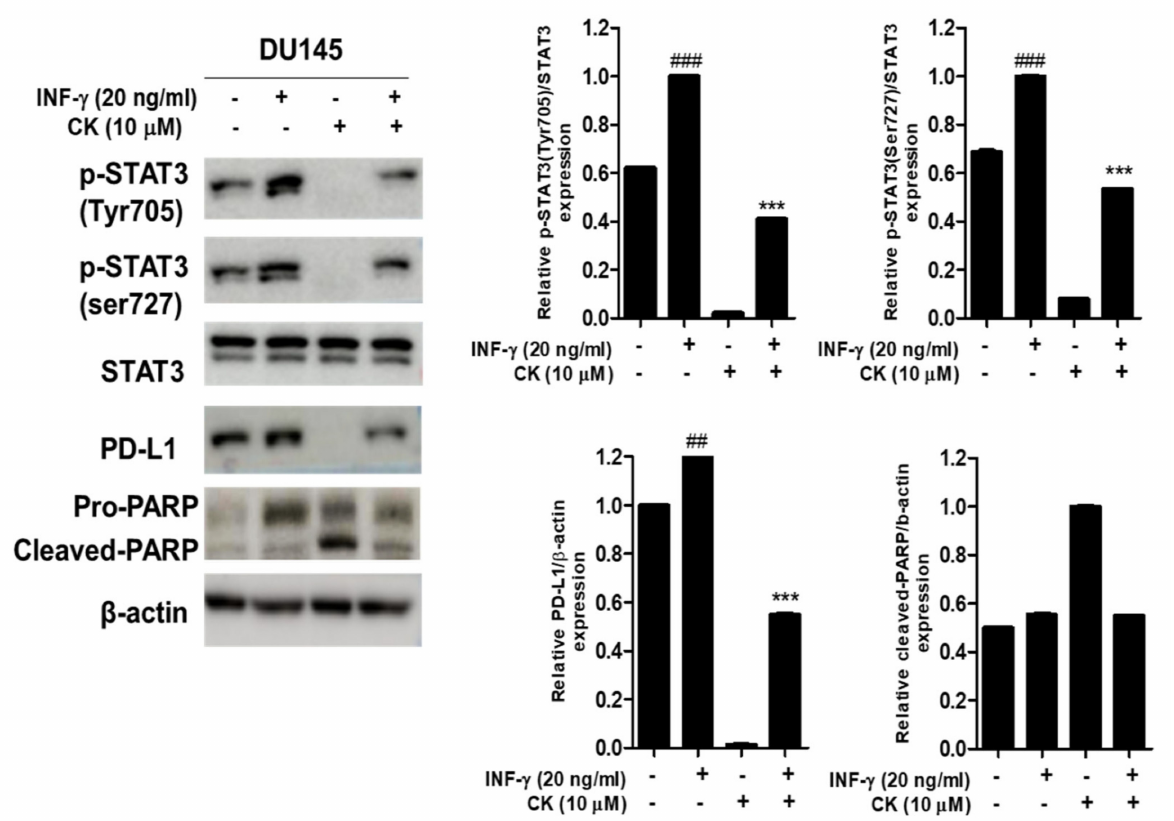
Figure 5. Effect of compound K on INF- γ stimulated p-STAT3 and PD-L1 in DU145 cells. DU145 cells were treated with 10 µ M CK and 20 ng/mL recombinant human INF- γ protein for 24 h and were subjected to Western blotting for p-STAT3 (Tyr705), p-STAT3 (ser727), STAT3, PD-L1 and β -actin. Graphs represent relative levels of protein/ β -actin. Data are shown as means ± SD. ## p < 0.01 vs. untreated control. ### p < 0.001 vs. untreated control. *** p < 0.001 versus INF- γ treated